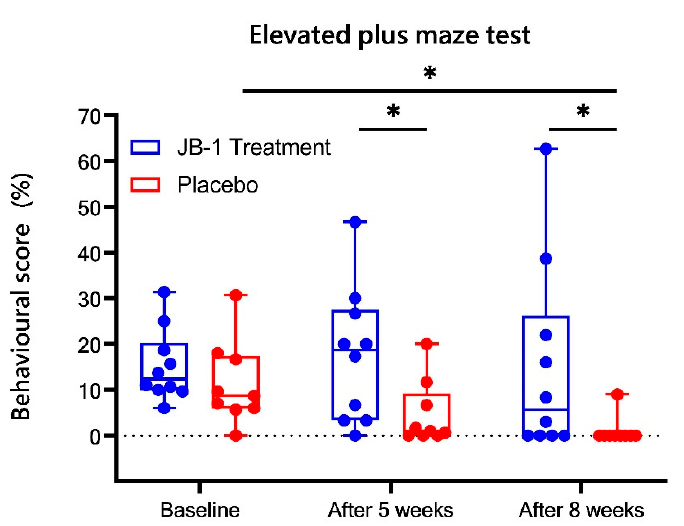
Figure 2. A ratio of time spent in the open arms of the maze (%) as a quantitative measure of behavioural score in the Elevated Plus Maze (EPM) behavioural test results in JB-1 treatment (N = 10) and placebo (N = 9) groups at baseline and after five and eight weeks of the stress protocol. Data are presented as median ± min/max. * p < 0.05, two-way ANOVA analysis for repeated measures with post-hoc Duncan’s test.